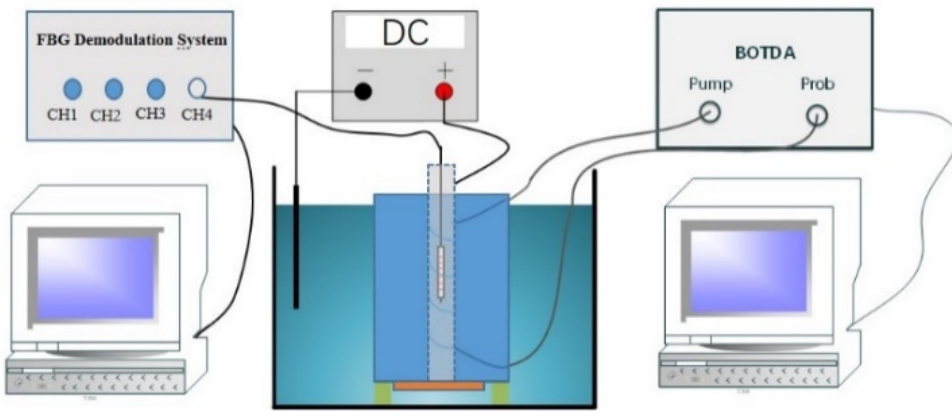
Figure 8. Schematic diagram of test device.